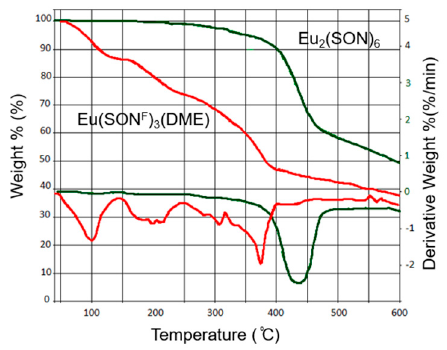
Figure 1. TGA of complexes Eu(SON F ) 3 (DME)—red, and Eu 2 (SON) 6 —green.